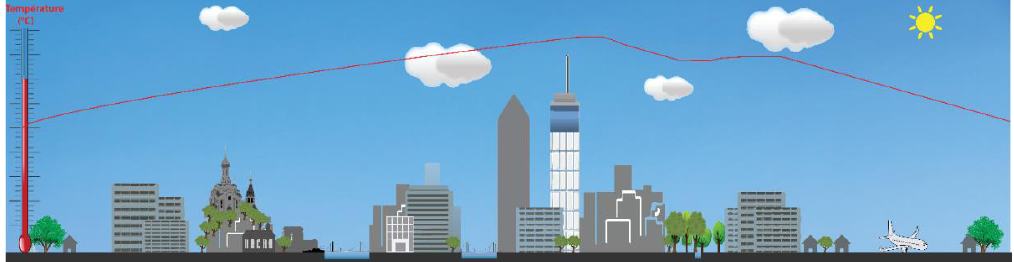
Figure 1. Schematic drawing of a horizontal profile of an urban heat island in the Lyon metropolitan area.